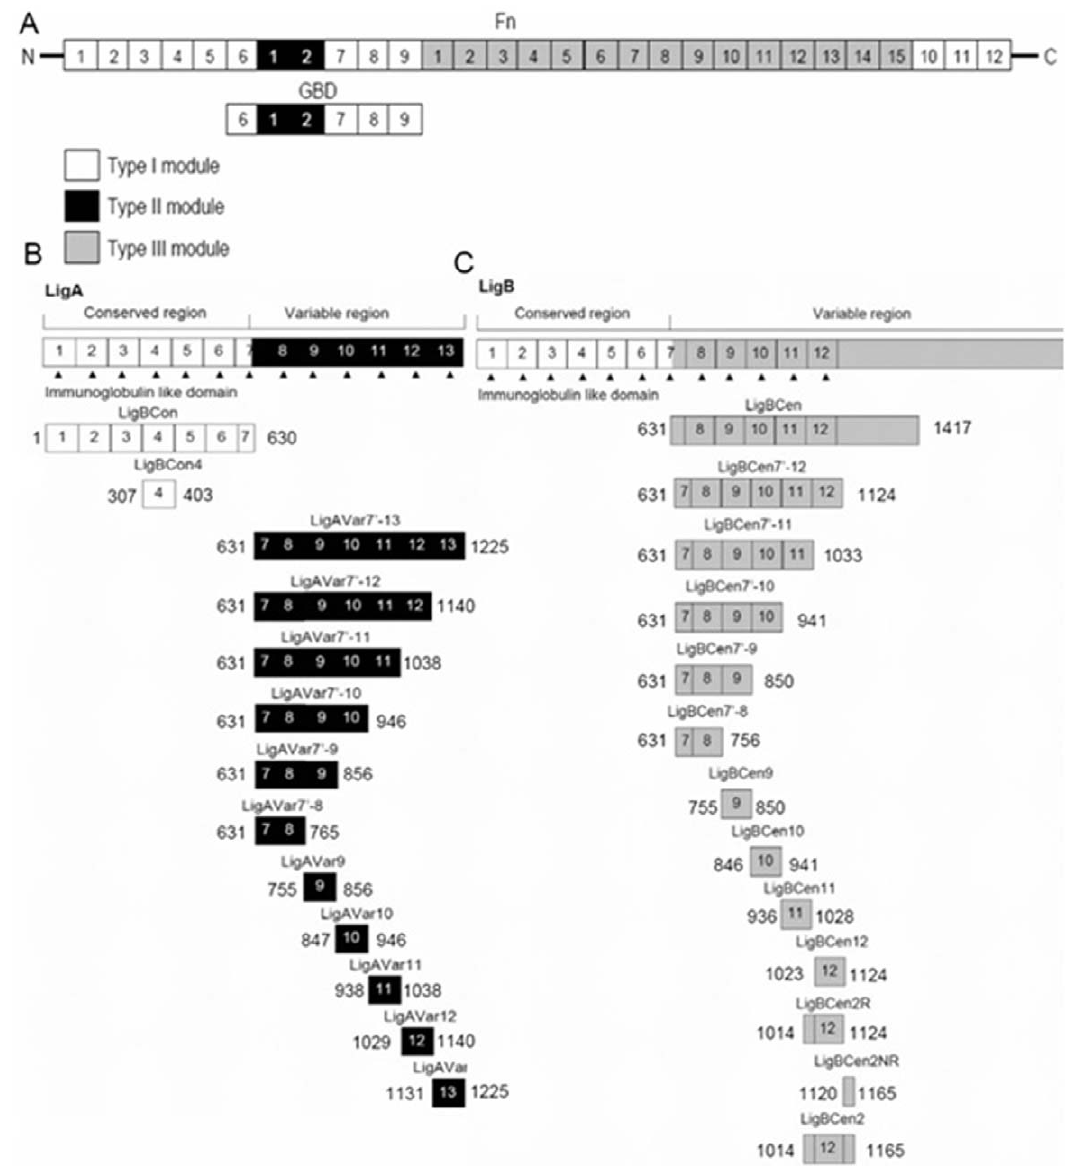
Figure 6. A schematic diagram showing the structure of truncated (A) Fn, (B) LigA, and (C) used in this study. doi:10.1371/journal.pone.0011301.g006 frictional ratio (f 0 20,w /f 0 ) of truncated Lig proteins defined in equation 4 [47].